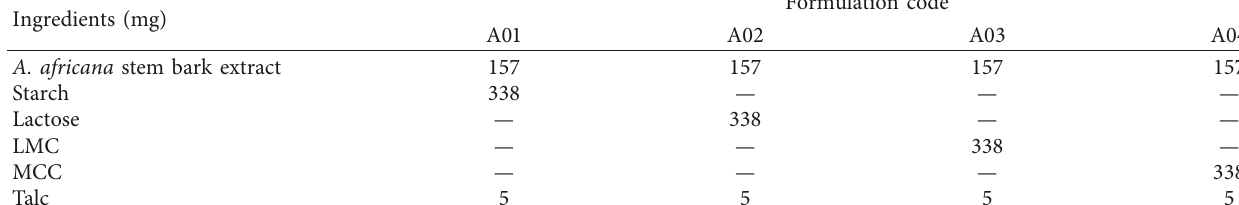
Table 1: Composition of Antiaris